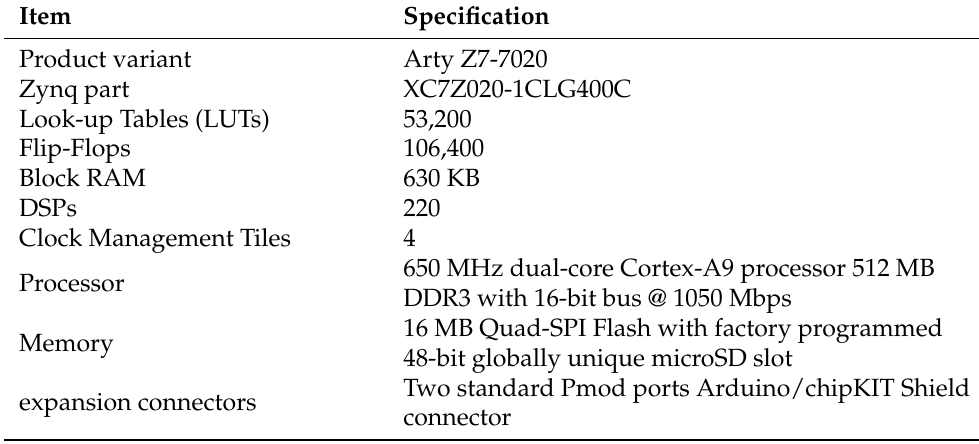
Table 4. Some specifications of Arty Z7-7020 development